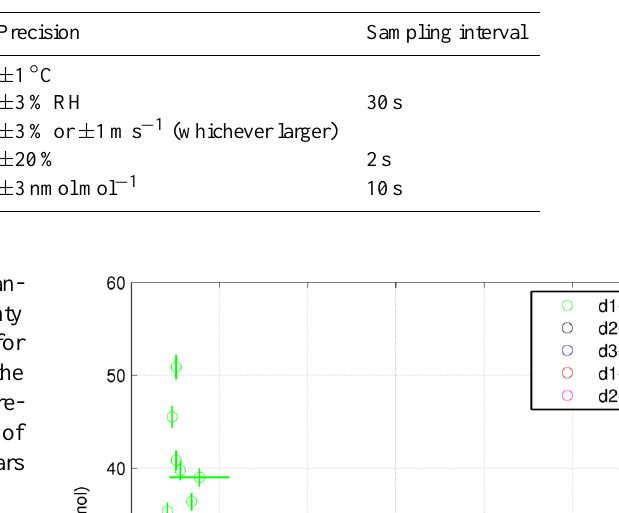
Table 2. Instruments used at the near crater sites.